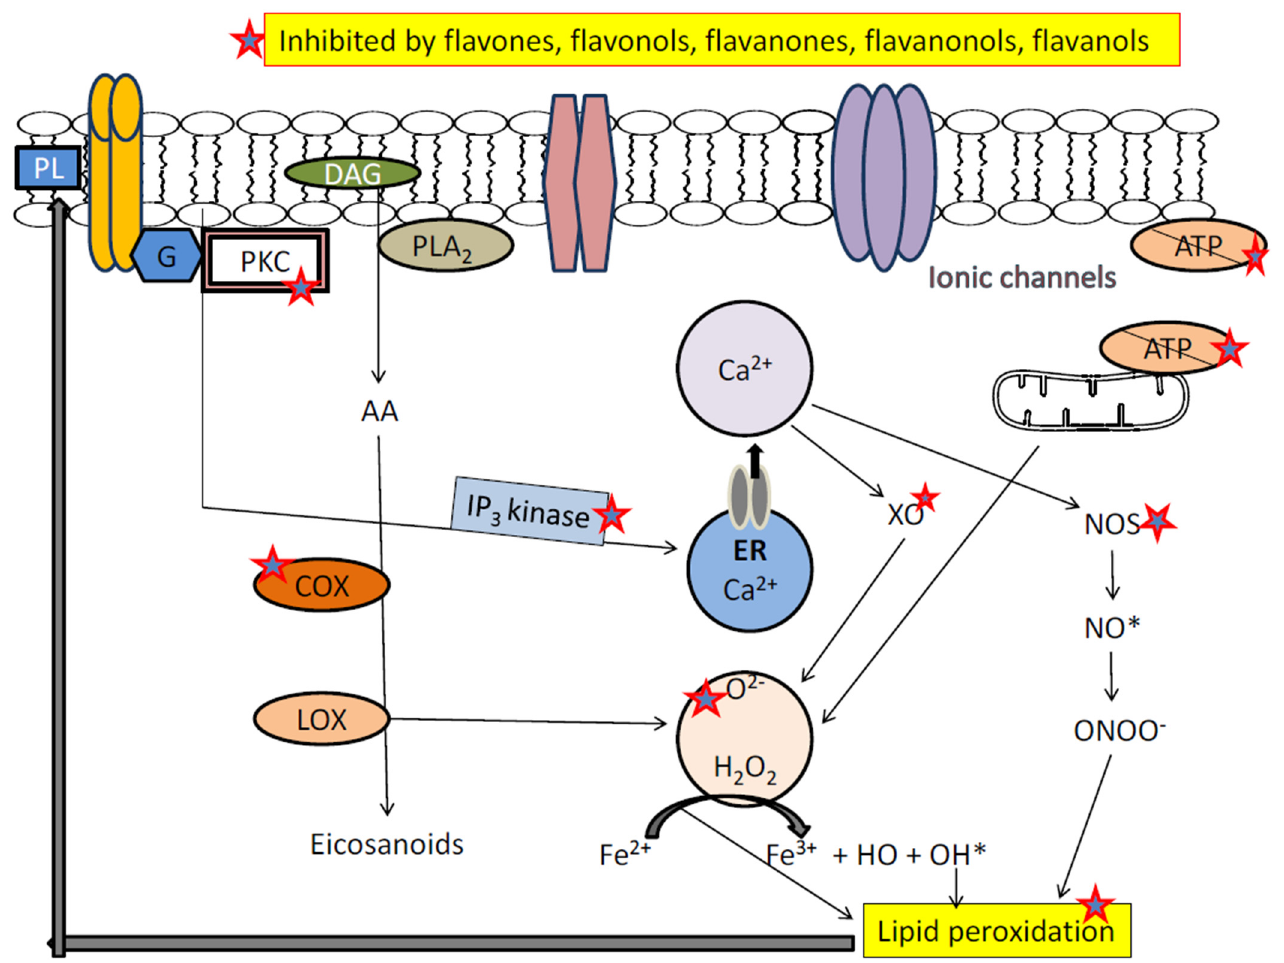
Figure 48. Inhibitory effect of flavonoids on lipid-peroxidation. PL, phospholipids; PKC, protein kinase C; DAG, diacylglycerol; PLA2, phospholipases A2; AA, arachidonic acid; COX, cyclooxygenase; LOX, lipoxygenases; IP3, inositol trisphosphate; ER, endoplasmic reticulum; ATP, adenosine triphosphate; NOS, nitric oxide synthase.